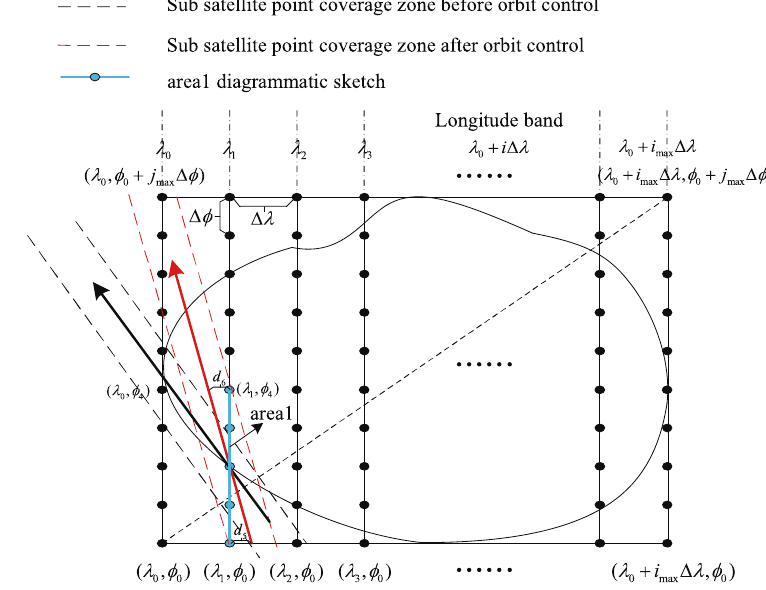
Figure 3: Schematic diagram of the existing satellite optimization scheduling